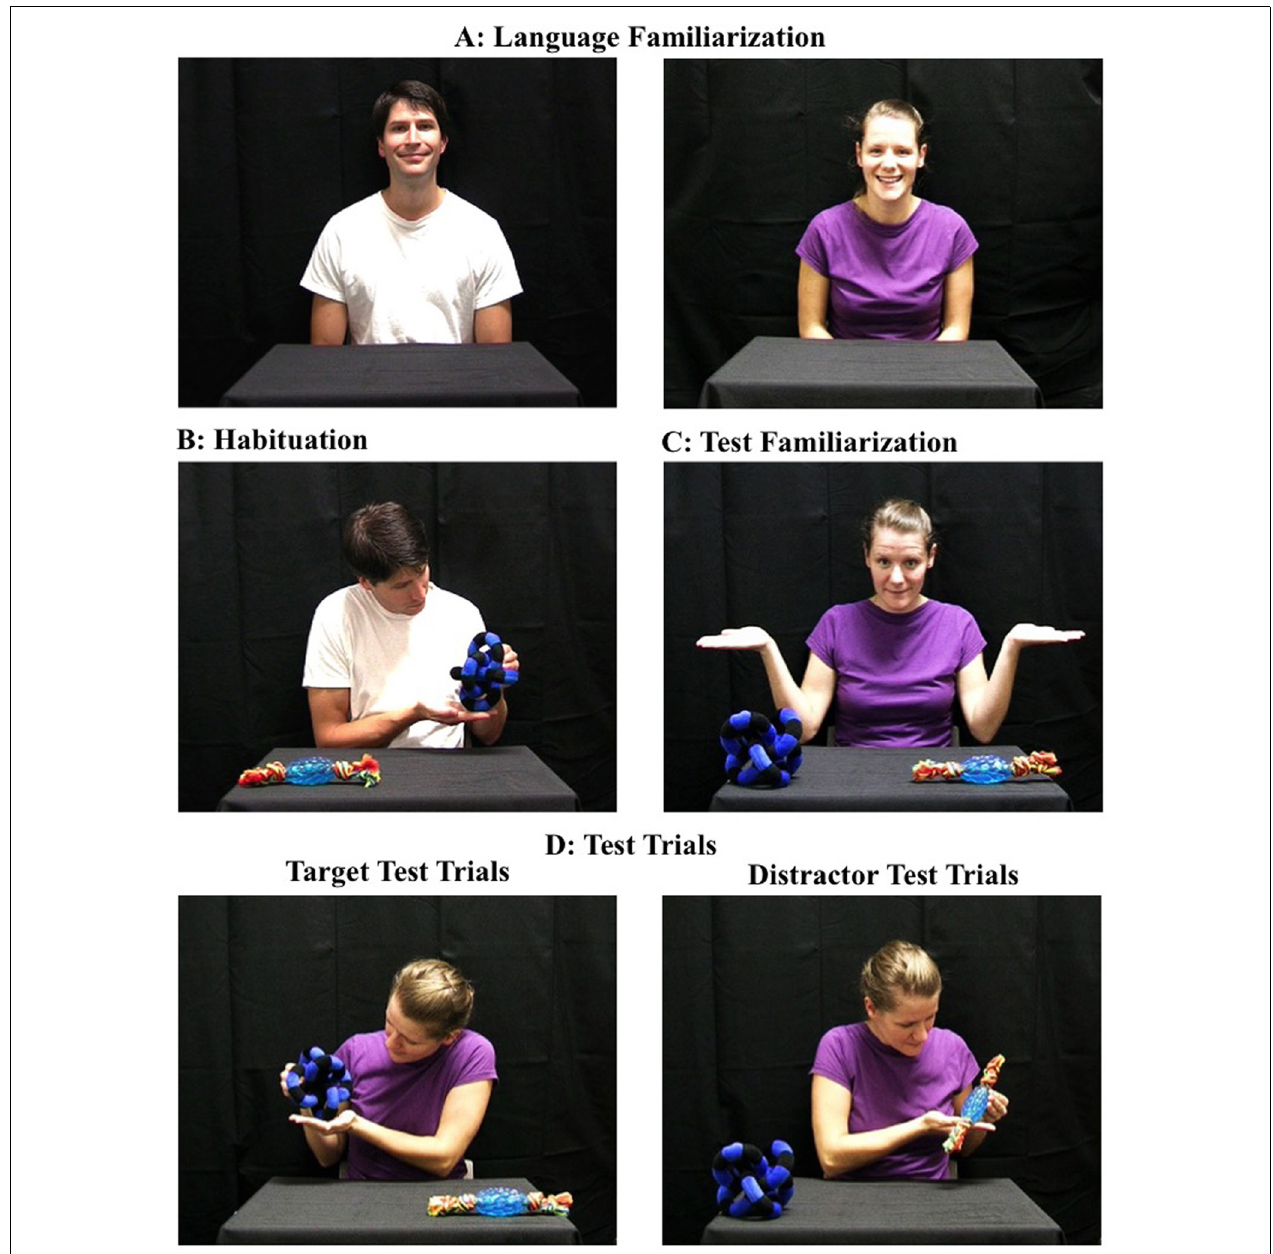
FIGURE 1 | Sample image of the language familiarization, habituation, test familiarization, and test trials used in this research.